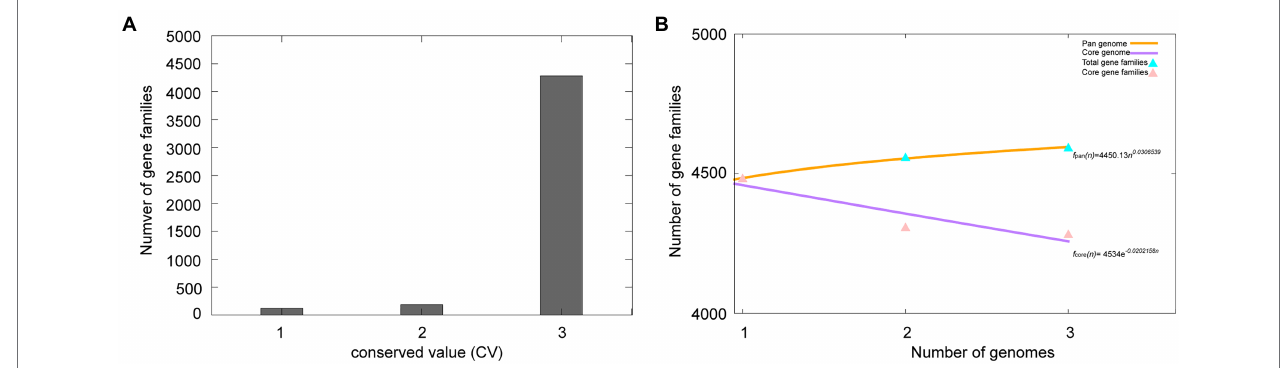
FIGURE 3 | Overview of the pan-genome generated by Bacterial Pan-genome Analysis (BPGA) using three strains of the species Modestobacter deserti . (A) The gene family frequency spectrum. (B) The pan genome profile trends of the species Modestobacter deserti obtained using clustering tools